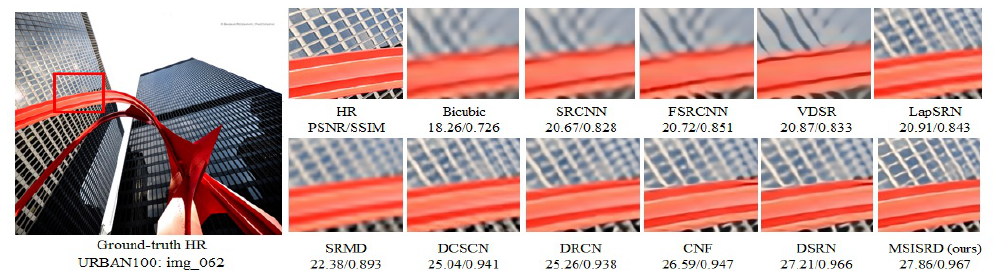
Figure 9. Visual performance of the image “img-062” from URBAN100 [23] dataset with 4 × scale factor enlargements [70].